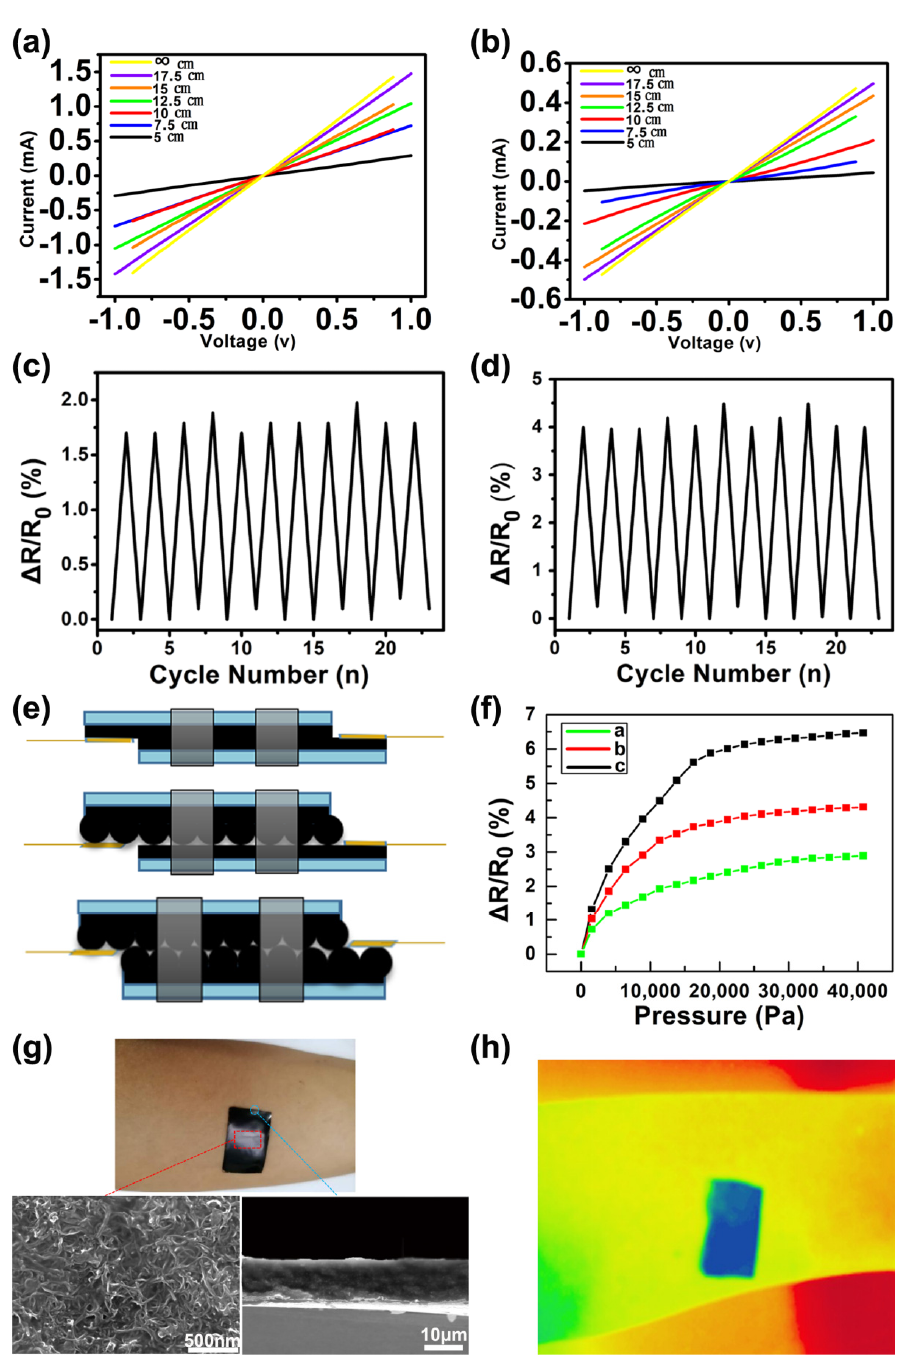
Figure 3. ( a ) Sensitivity of different pressure sensors based on 2 μ m and 5 μ m sized PS sphere. ( b ) Schematic illustration of the alterations that occur when the equal external pressure is applied to the pressure sensors based on 2 μ m and 5 μ m sized PS spheres. ( c , d ) Finite element modeling of the stress distribution and deformation of the sensors based on 2 μ m and 5 μ m diameter PS mi- crospheres at 1 kPa applied pressure.